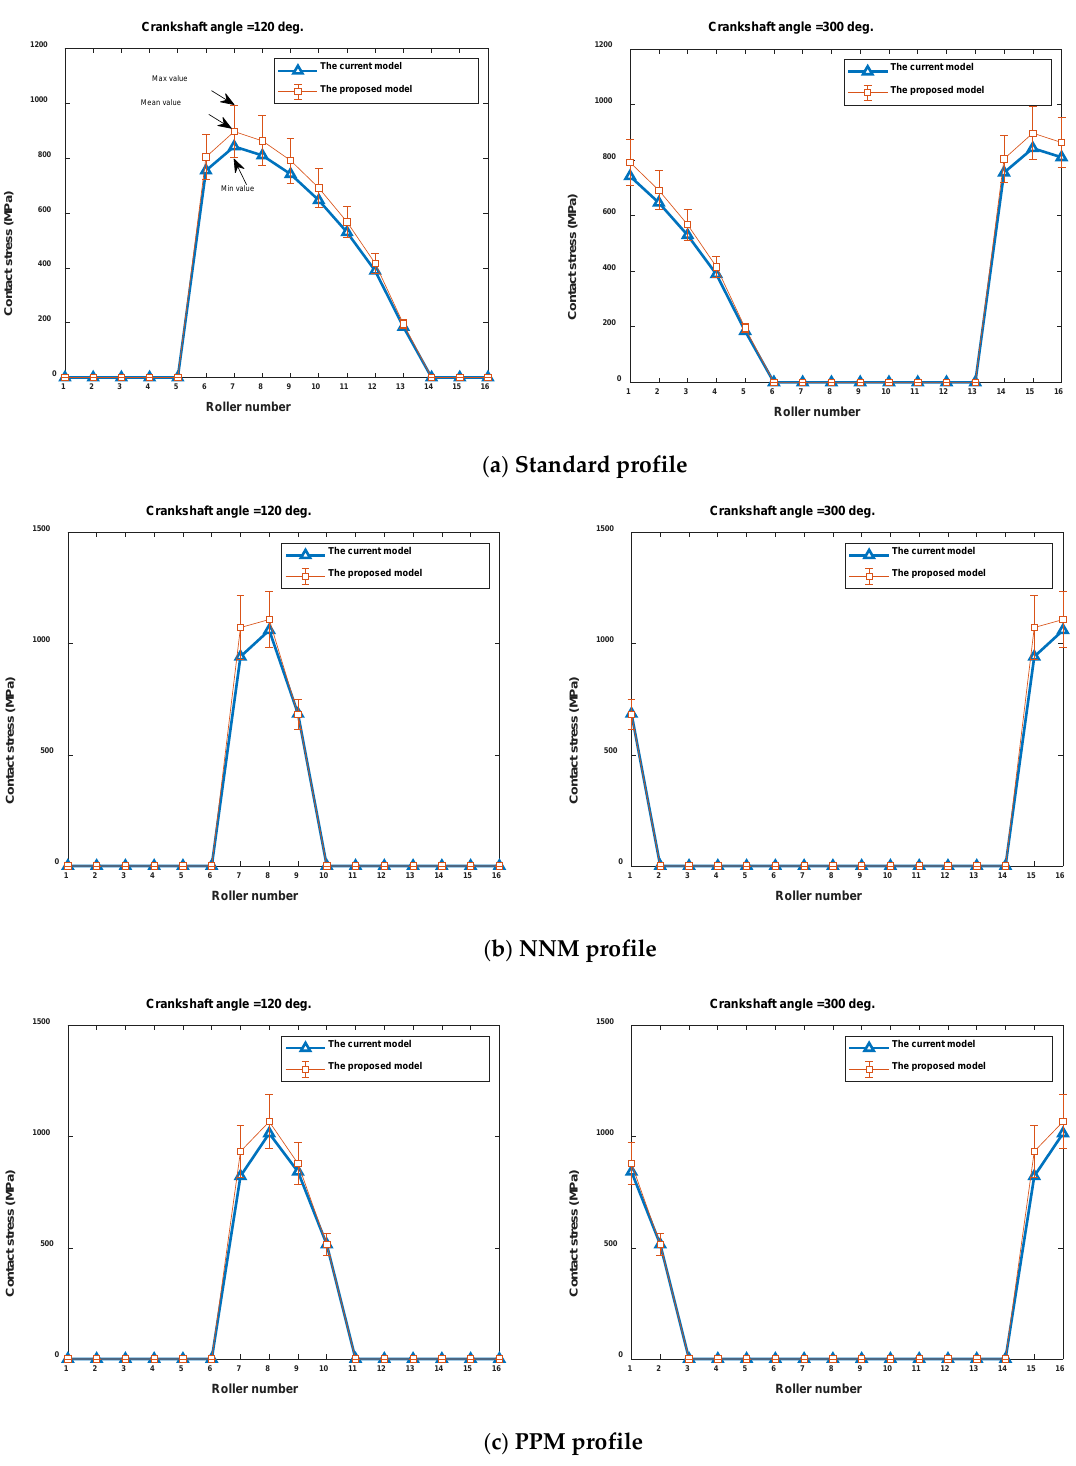
Figure 9. Comparison of contact stress on tooth pairs at 120° and 300° crankshaft angles obtained by the current model and the proposed model for the cases of ( a ) standard, ( b ) NNM, and ( c ) PPM profiles. Figure 10 shows the LTE and the GR of the example cycloid gear pair calculated by the current model and the proposed model for the three cases. These time histories illustrate that the same shape and period of the LTE and the GR were obtained by both models, varying periodically as the crankshaft rotates, as expected, while the average absolute value of LTE and the peak-to-peak value of the GR obtained by the proposed model are a little smaller than those obtained by the current model.